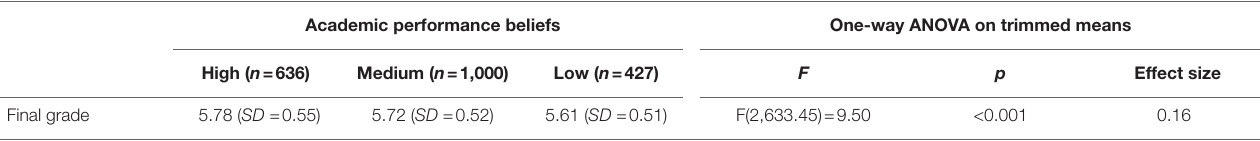
TABLE 2 | Differences in academic performance obtained by participating students at the end of the semester (T2) as a function of performance beliefs during the ERT (T1). Academic performance beliefs One-way ANOVA on trimmed